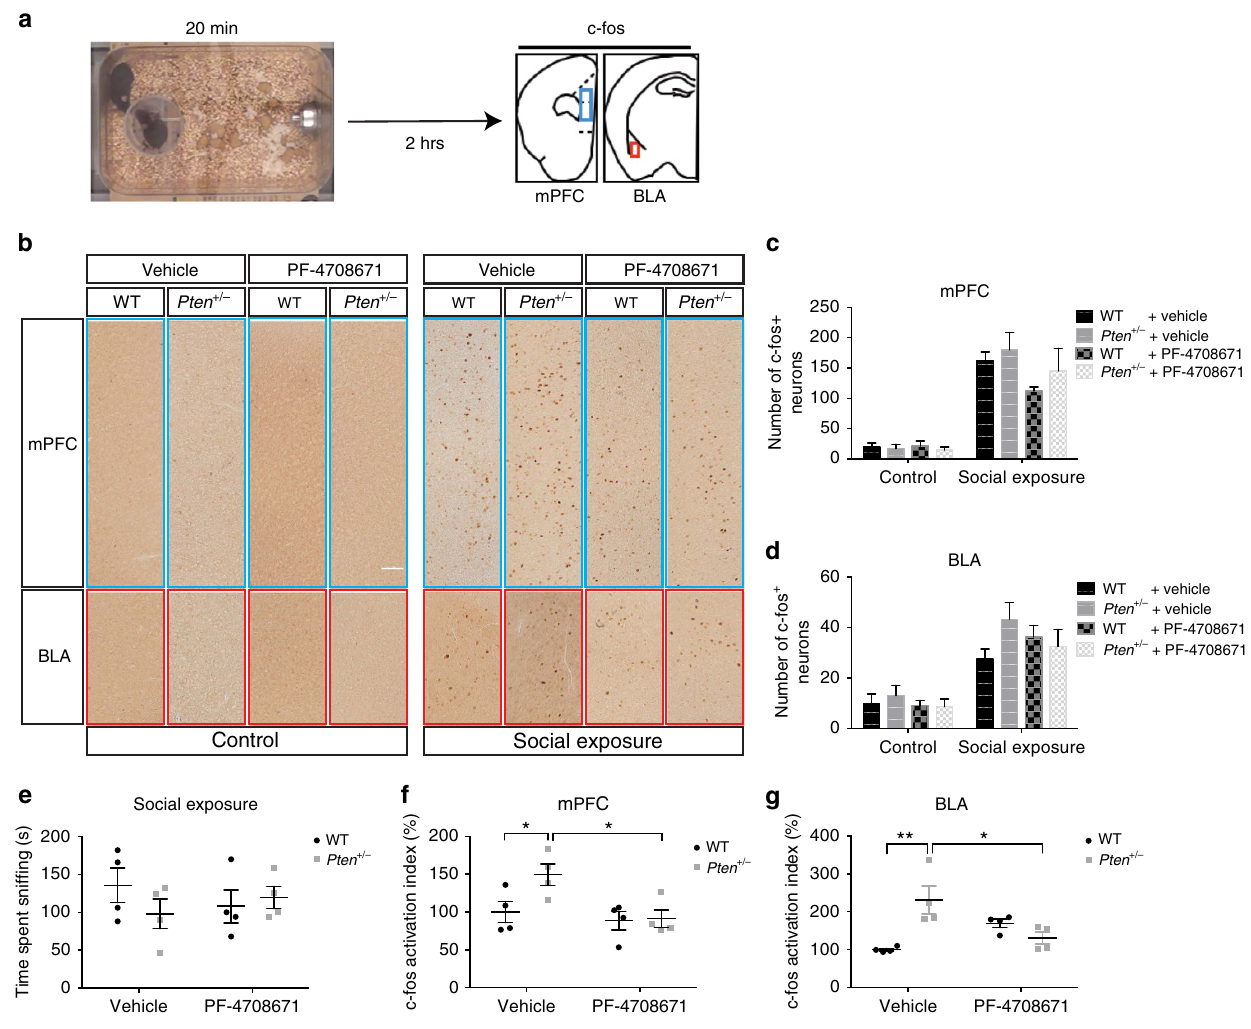
Figure 4 | mPFC and BLA hyperactivity in Pten mutant mice is corrected by inhibition of S6K1 during development. ( a ) Diagram showing the workflow of social exposure and c-fos staining. Adult mice were exposed to a novel mouse for 20min, perfused 2h later, and then underwent c-fos staining to measure neuronal activity in the mPFC and BLA. ( b – d ) Representative images ( b ) and quantification of c-fos staining in the mPFC ( c ) and the basal lateral amygdala (BLA) ( d ) of control or social exposed WTand Pten þ / (cid:2) mice receiving either vehicle or PF-4708671 from postnatal day 4 (P4) to P14. Scale bar, 100 m m. N ¼ 4 animals in each group. ( e ) Graph showing social interaction time, reflected as time spent sniffing, in WTand Pten þ / (cid:2) mice receiving either vehicle or PF-4708671 from P4 to P14. N ¼ 4 animals in each group. ( f , g ) Quantification of c-fos activation index (number of c-fos þ neurons/time spend sniffing) in the mPFC ( f ) and BLA ( g ) of social exposed WT and Pten þ / (cid:2) mice receiving either vehicle or PF-4708671 from P4 to P14. Planned comparisons revealed a significant difference between WT and Pten þ / (cid:2) mice receiving vehicle, and a significant difference between vehicle and PF-4708671-treated Pten þ / (cid:2) mice. For ( f ) two-way ANOVA revealed a main effect on drug. F (1,12) ¼ 3.194, P ¼ 0.099 (interaction), F (1,12) ¼